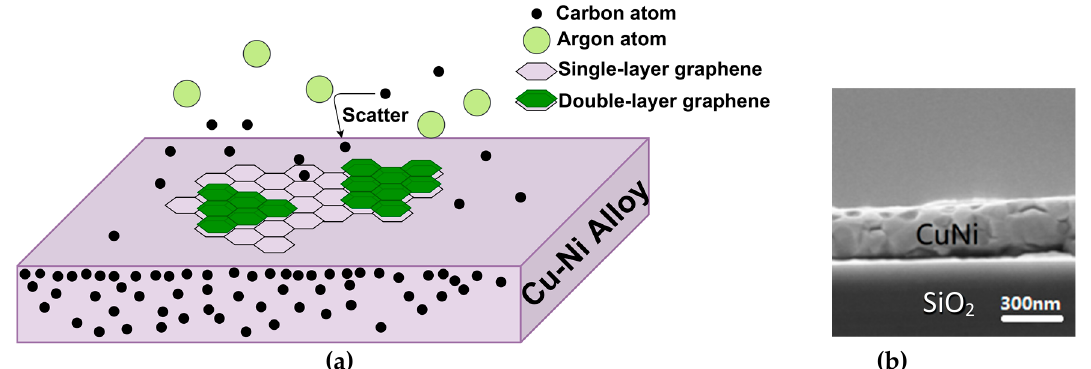
Figure 3. ( a ) Schematic diagram of the deposition of graphene by GD method on the Cu-Ni alloy. The carbon atoms resulted from the plasma etching of the graphite electrode are transported to the metal catalytic surface via scattering. ( b ) Scanning electron microscope (SEM) image (cross-sectional view) of the Cu-Ni alloy after annealing at 900 °C.